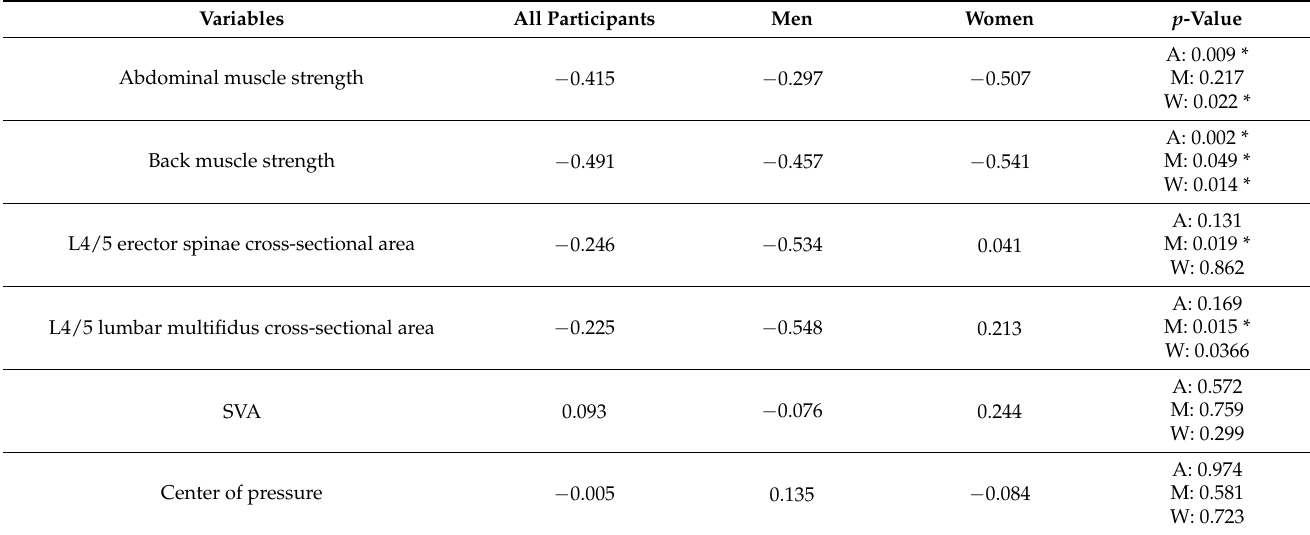
Table 3. Correlation between the fall score and abdominal and back muscle strength and L4/5 erector spinae and lumbar multifidus cross-sectional